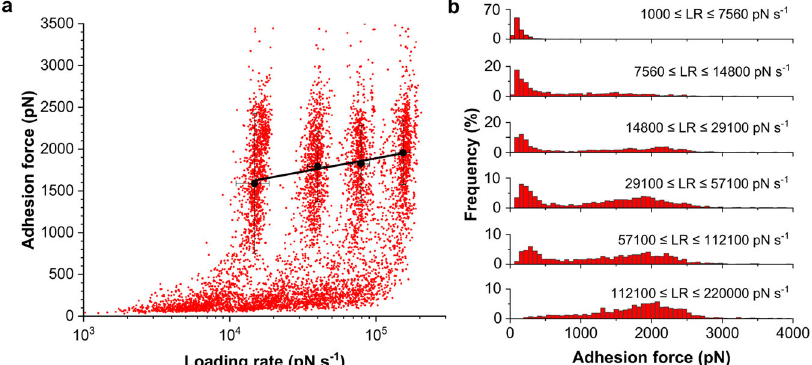
Fig. 4 Physical stress enhances the strength of the SdrE-fH interaction. a DFS plot showing the adhesion force as a function of the logarithm of the loading rate ( LR ) applied during retraction, while keeping constant the interaction time (50 ms) and the approach speed (1,000 nm s − 1 ). Data pooled from fi ve SdrE ( + ) cells (total of n = 5358 adhesive events). Bell-Evans fi t (black line) through the most-probable forces showing the expected loading-rate dependency and x u = 0.03 nm and k off = 9.4 ×10 − 4 s − 1 . Error bars represent the standard deviations. b Adhesion force histograms as a function of discrete ranges of loading rates documenting a major shift towards higher forces with increasing LR